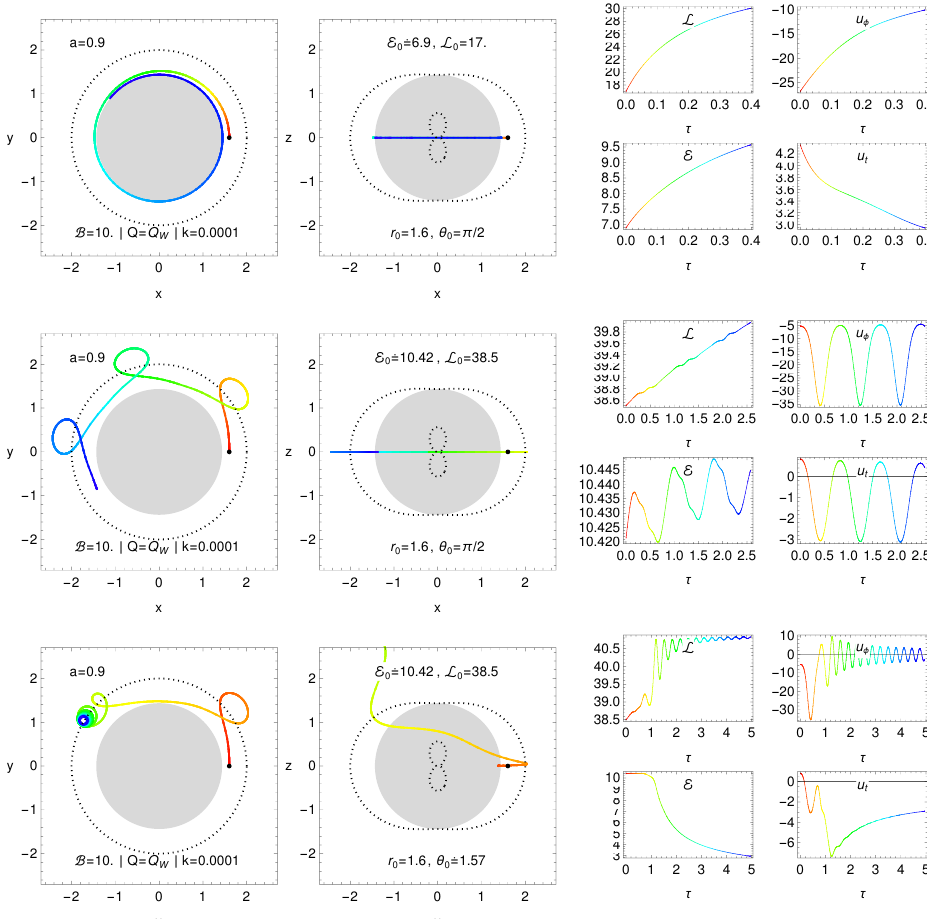
Figure 9. The energy gain in the RPP due to radiating force in the ergosphere. Three basic types of the orbits are presented: the collapsing orbit gaining the energy while being finished in the black hole, the floating orbit where the radiating particle successively gains energy during the motion inside the ergosphere and looses the energy during the motion outside the ergosphere, and the escaping orbit where the particle is gaining energy in the ergosphere and loosing the energy outside.